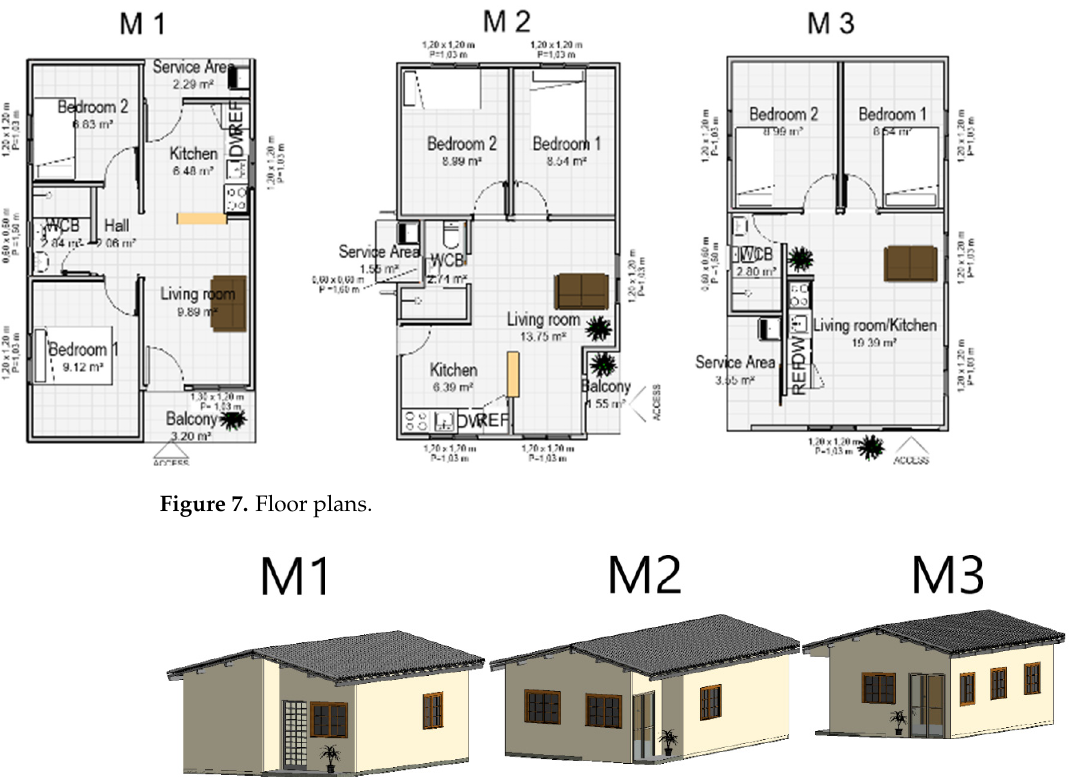
Figure 8. 3D views of the layouts.